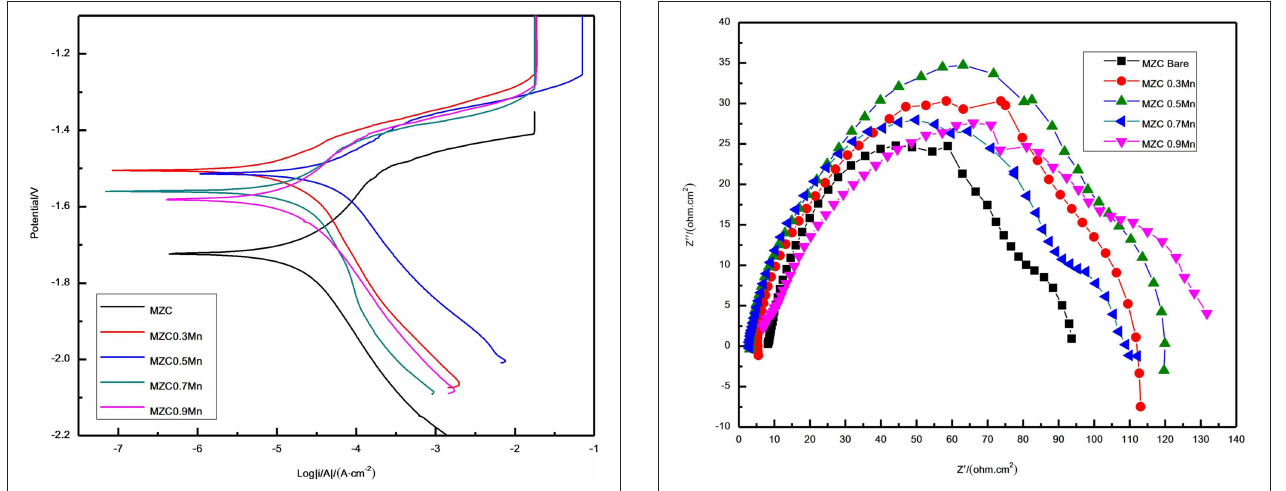
represents the charge transfer suppression. The larger